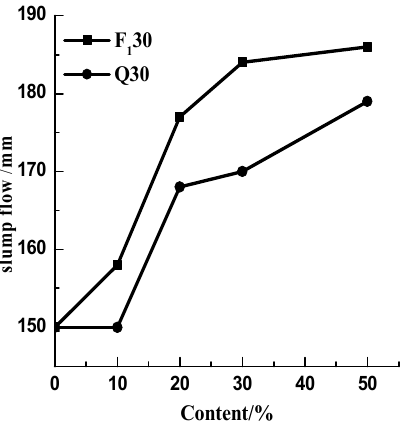
Figure 1. Comparison of the slump flow of mortars made of FA and Q.